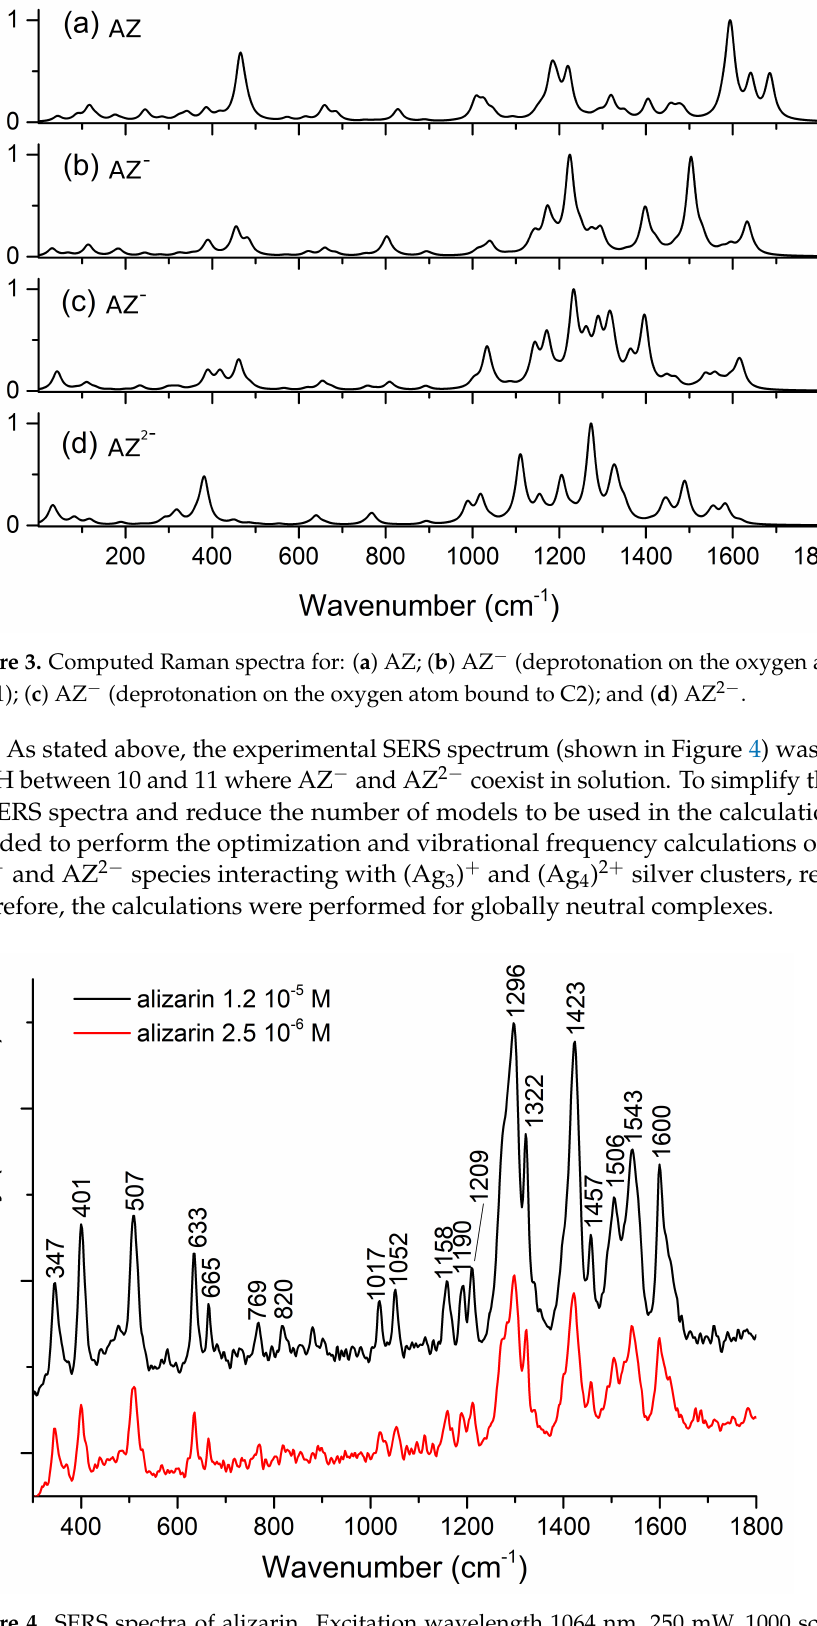
Figure 4. SERS spectra of alizarin. Excitation wavelength 1064 nm, 250 mW, 1000 scans. AgNP background has been